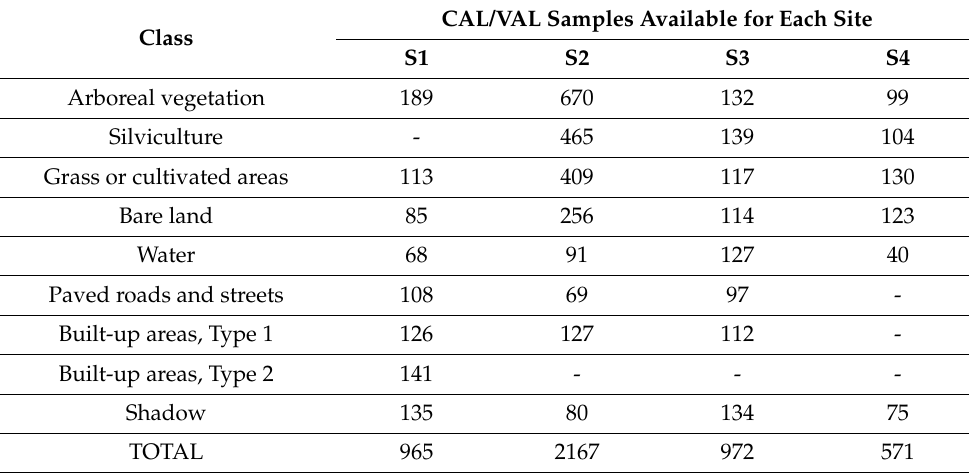
Table 2. Samples dataset used to train and validate the classification algorithms.